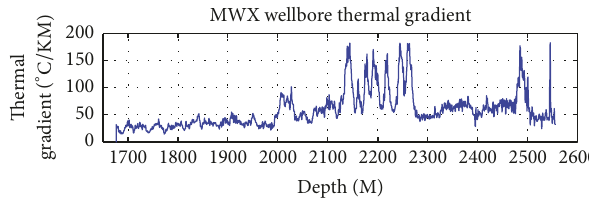
Figure 5: Thermal gradient wellbore log of MXW well between 1675 and 2520 meters.